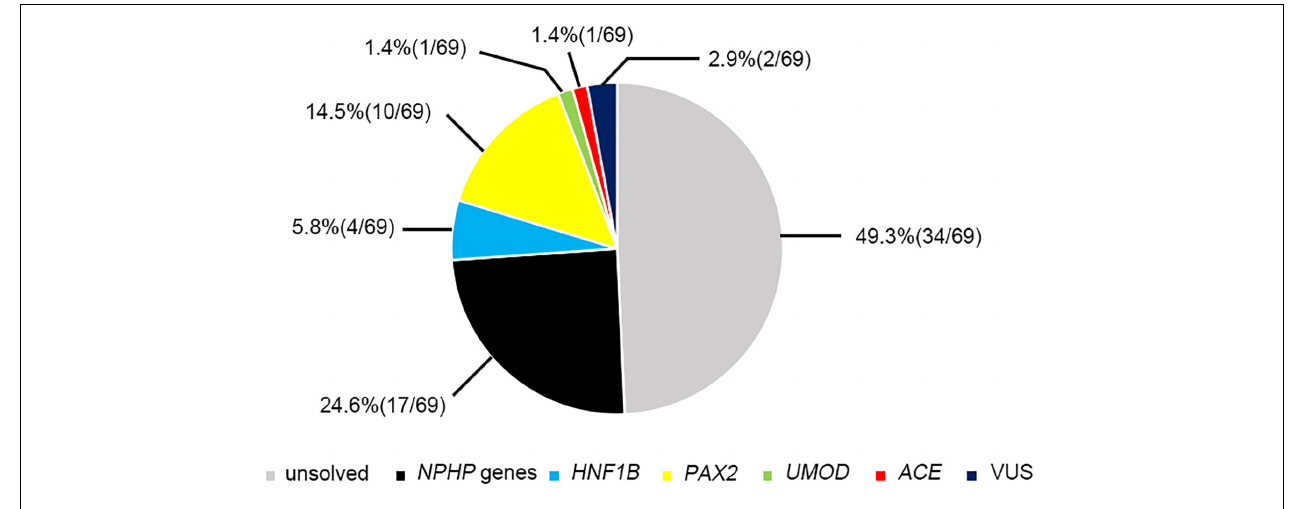
FIGURE 2 | The results of genetic examination in 69